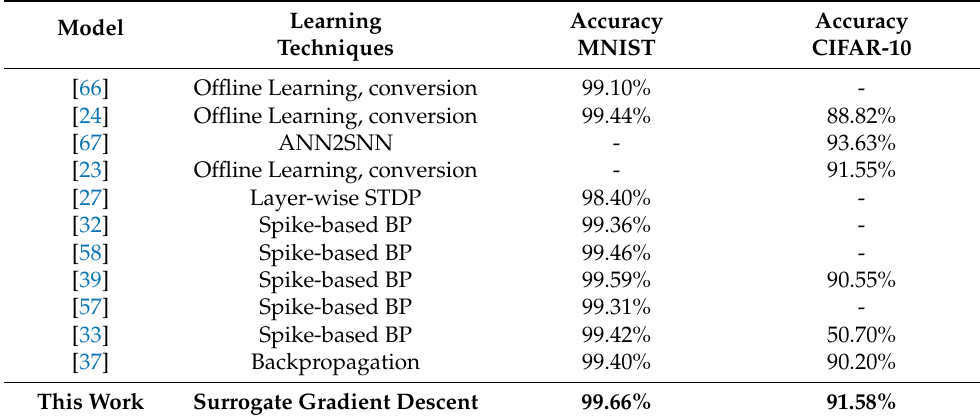
Table 5. SNN Classification Performance evaluation on MNIST and CIFAR-10 datasets.